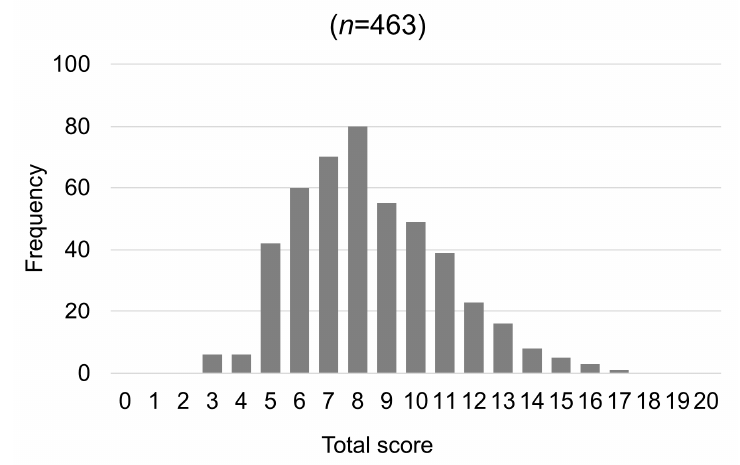
Figure 1. Distribution of the total scores.